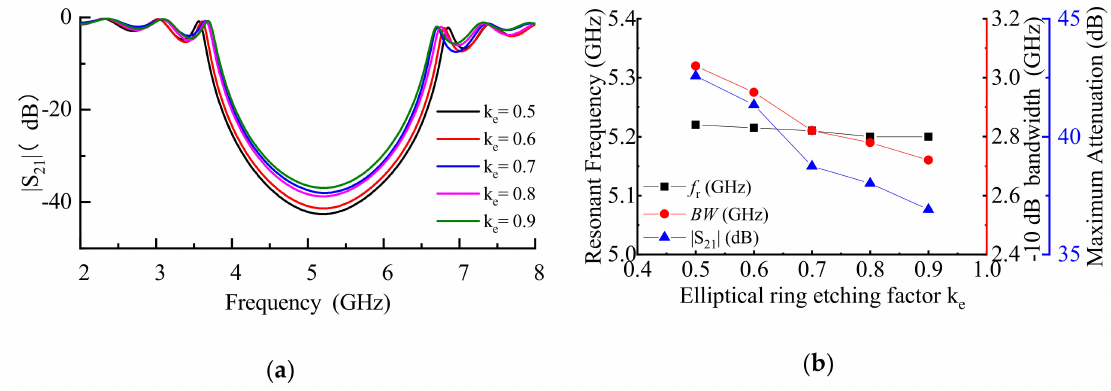
Figure 17. ( a ) Simulation results with di ff erent k e using HFSS; ( b ) maximum attenuation and − 10 dB fractional bandwidth with di ff erent k